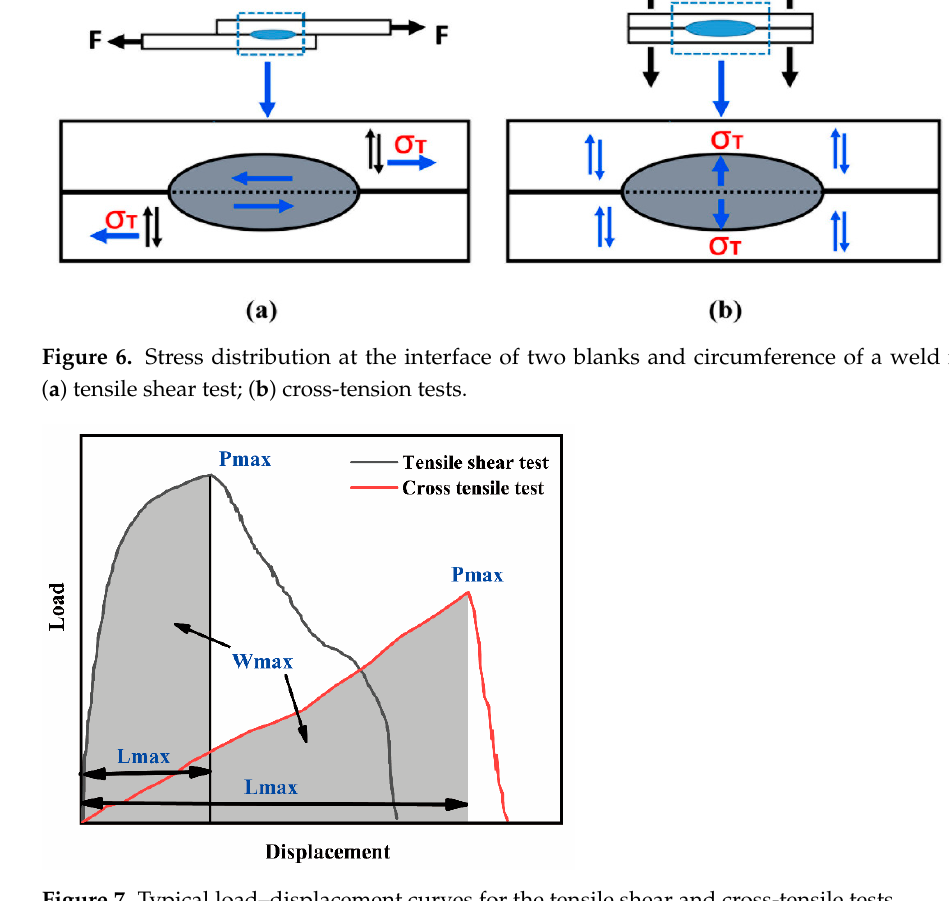
Figure 8. Load–displacement curves of high temperature tensile shear tests.